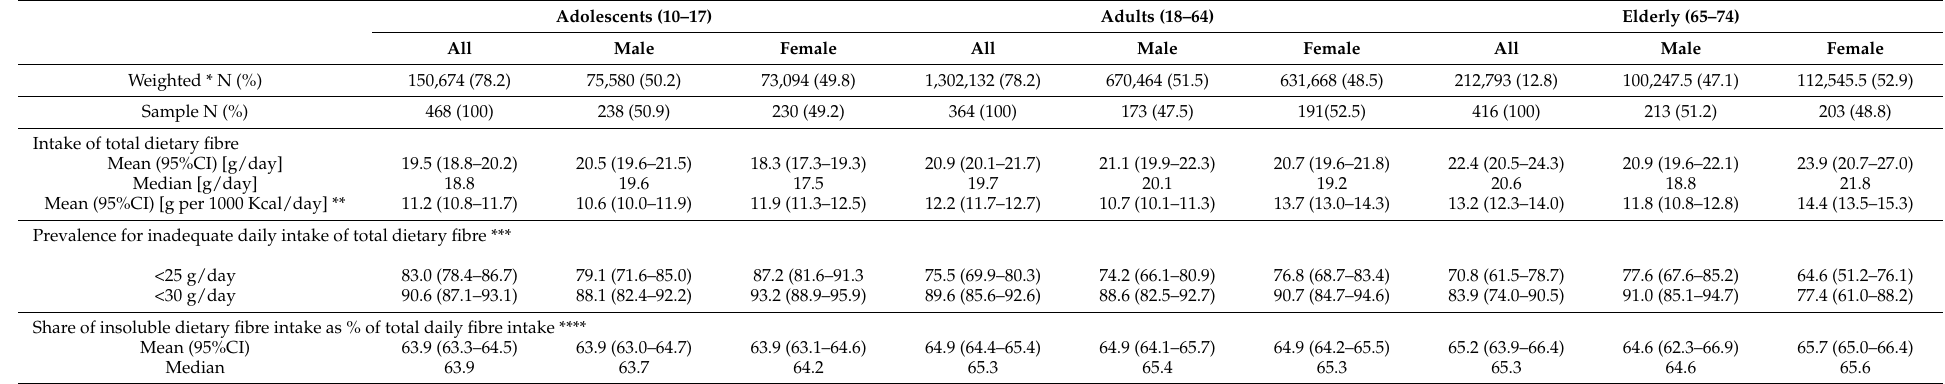
Table 2. Population-weighted usual daily dietary fibre intake and proportion of the population with inadequate daily fibre